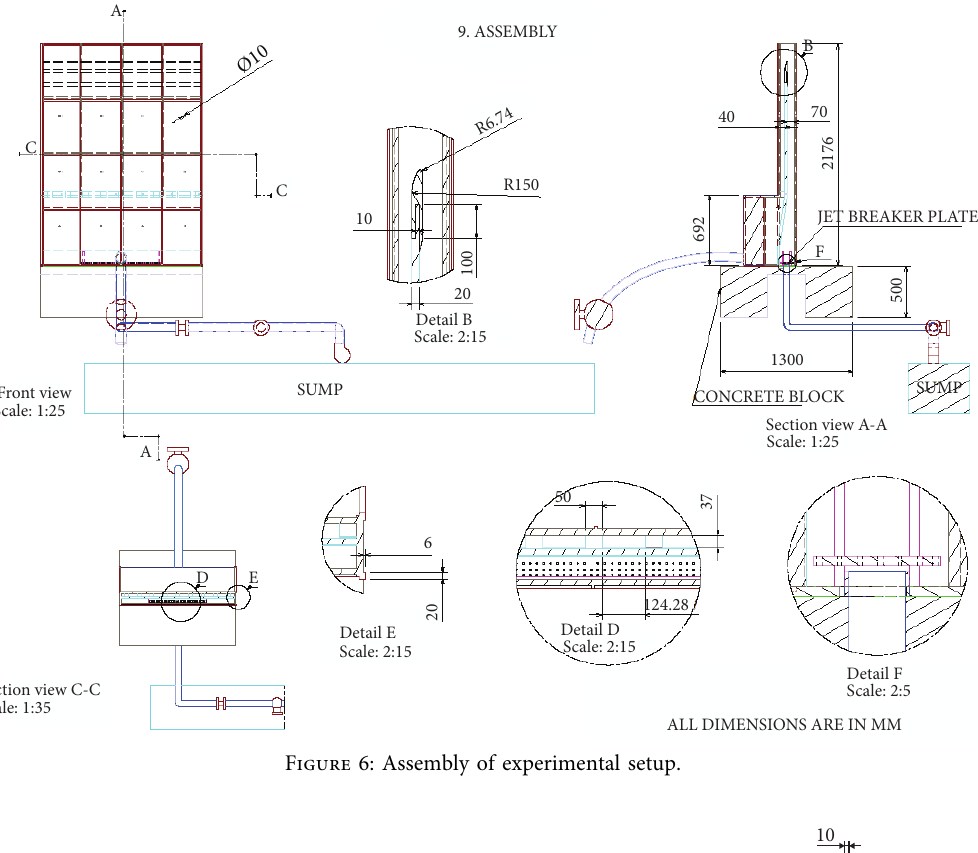
Figure 6: Assembly of experimental setup.